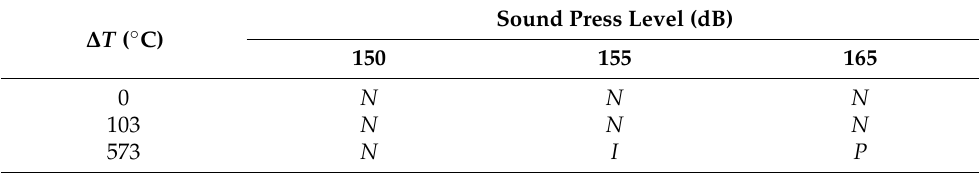
Table 2. Response characteristics of panel under different thermal-acoustic loadings.